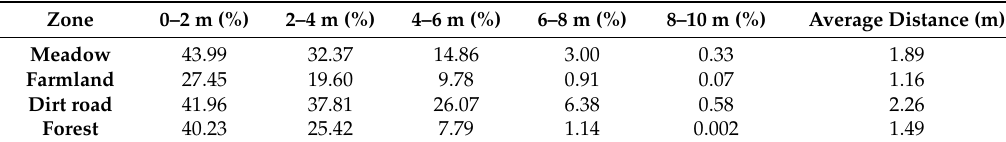
Table 3. Average number of shoots per stump and per age class as well as the plot and shoot database. Table 4. Zones 0–2 m, 2–4 m, 4–6 m, 6–8 m, 8–10 m and the average distance as spreading of black locust depending on the surrounding area: meadow, farmland, dirt road, and forest.